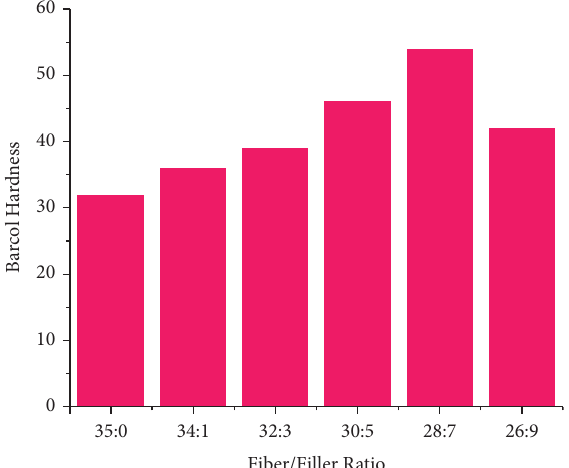
Figure 12: Effect of fibre/filler loading on Barcol hardness for epoxy resin/madar fibre/sugarcane bagasse ash composites.